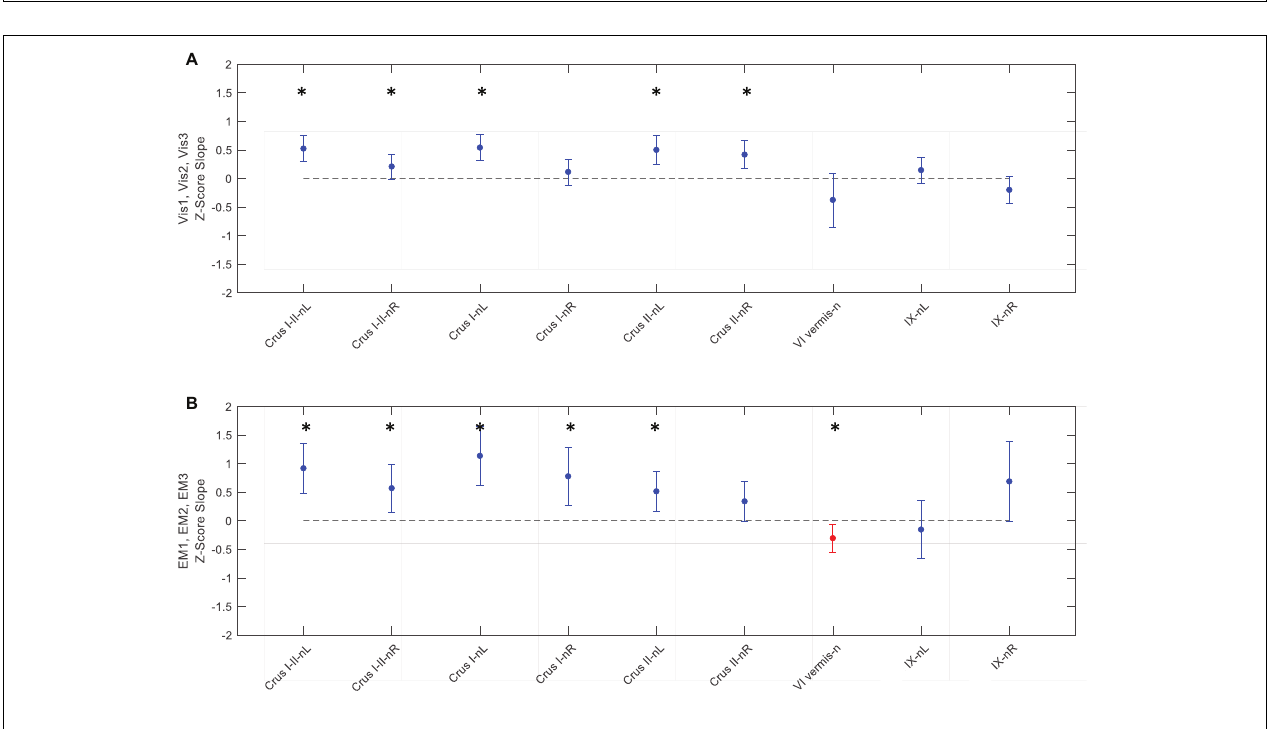
FIGURE 9 | Slopes of the evolution of response strengths (blue dots) for the task-negative ROIs from Figure 6 , with the same format and significance criteria as for Figure 8 . One ROI had positive activation (red dot) for the EM task (B) . Note that most of the task-negative Crus ROIs had significant slopes for the Vis task sequence (A) , with increasing negative response strength as the learning proceeded, thus deepening the suppression in these regions. A similar picture, with even greater suppression, is seen for the EM task sequence (B) . Asterisks indicate significant slopes at p < 0.05.